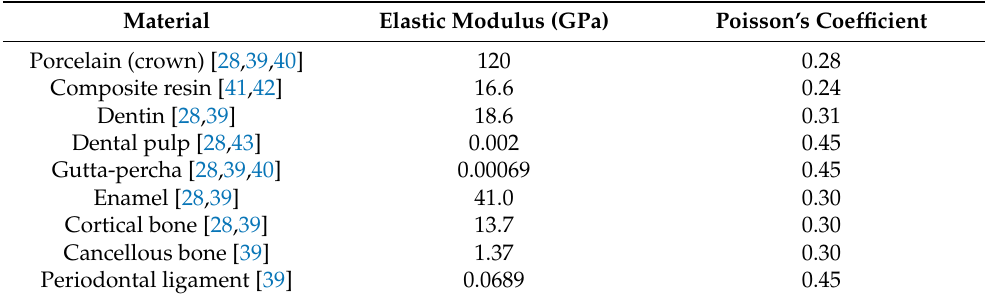
Table 2. Summarized elastic properties for the orthotropic materials used for the FEA. Table 1. Summarized elastic properties of the isotropic materials used for the FEA. Elastic